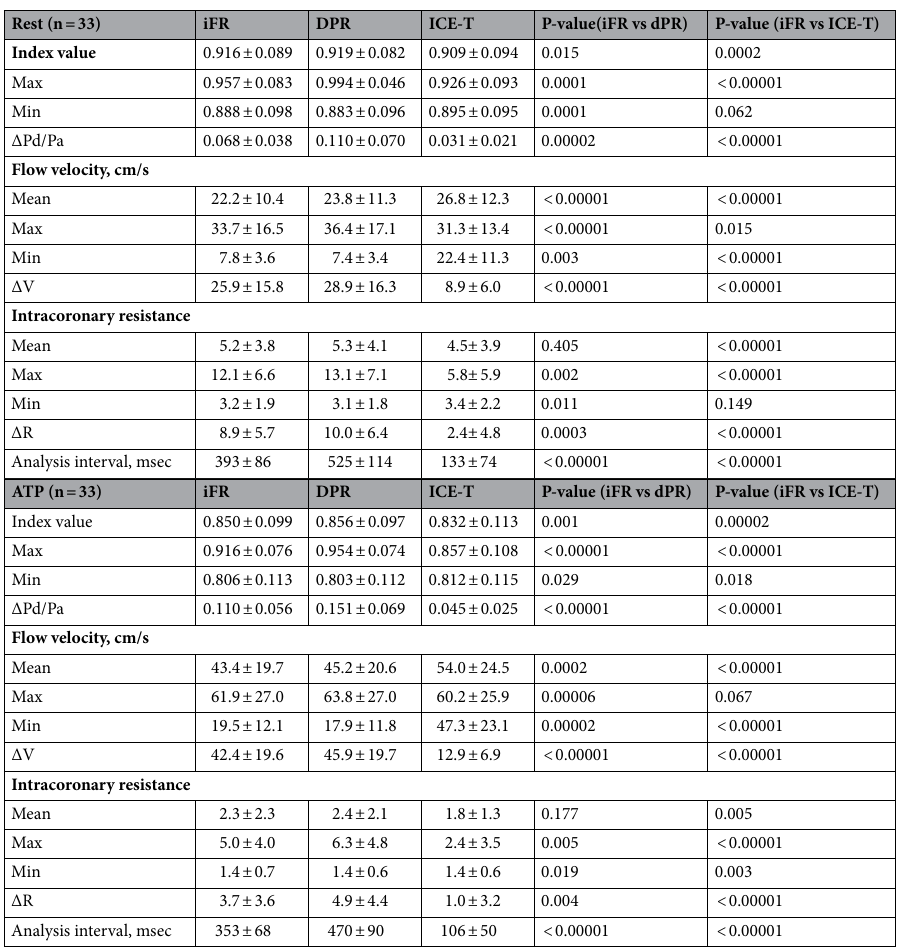
Table 2. Index pressure parameters, resistance, flow velocity, and the period used for the analysis. ATP adenosine triphosphate, DPR diastolic pressure ratio, ICE-T intracoronary electrocardiogram-triggered resting index, iFR instantaneous flow reserve.